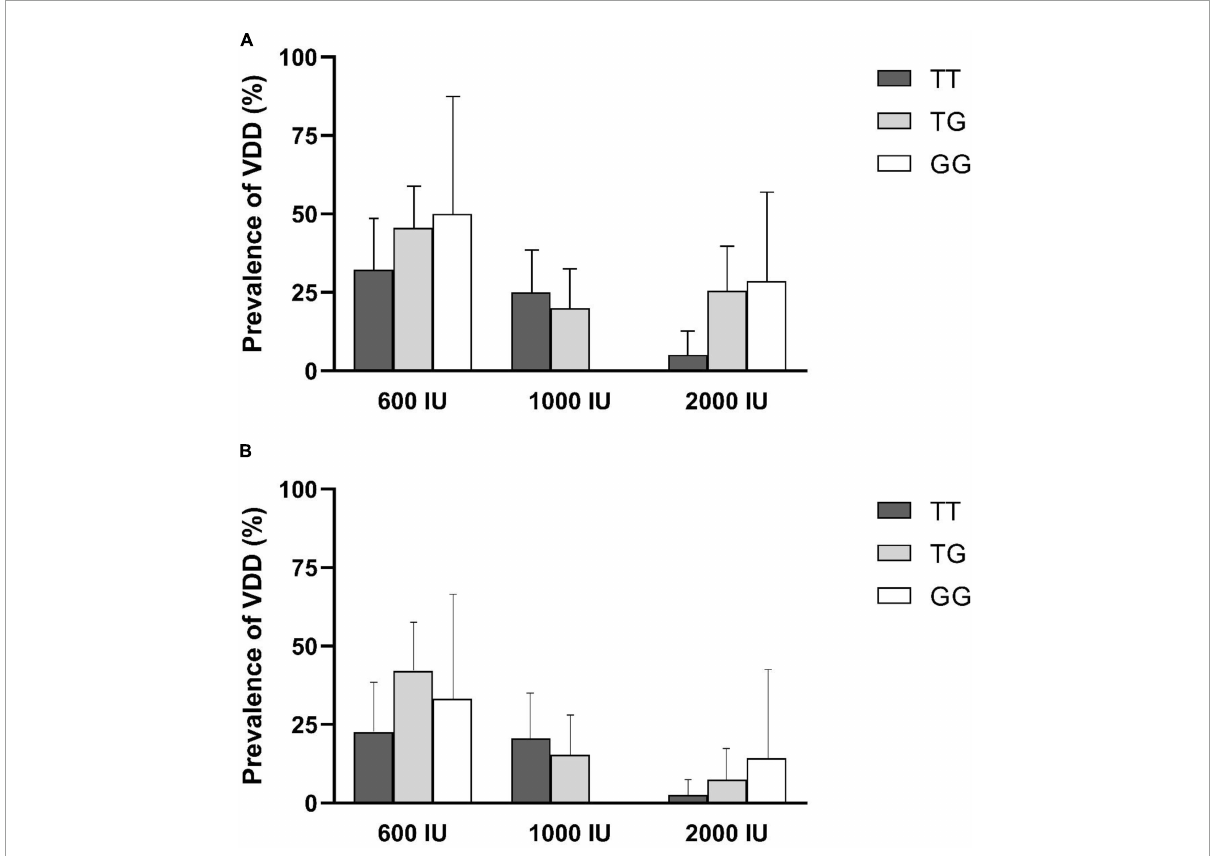
FIGURE2 Prevalence of vitamin D deficiency (VDD) by rs2282679 polymorphism in each treatment group. (A) 6-month percentage of VDD, (B) 12-month percentage of VDD.